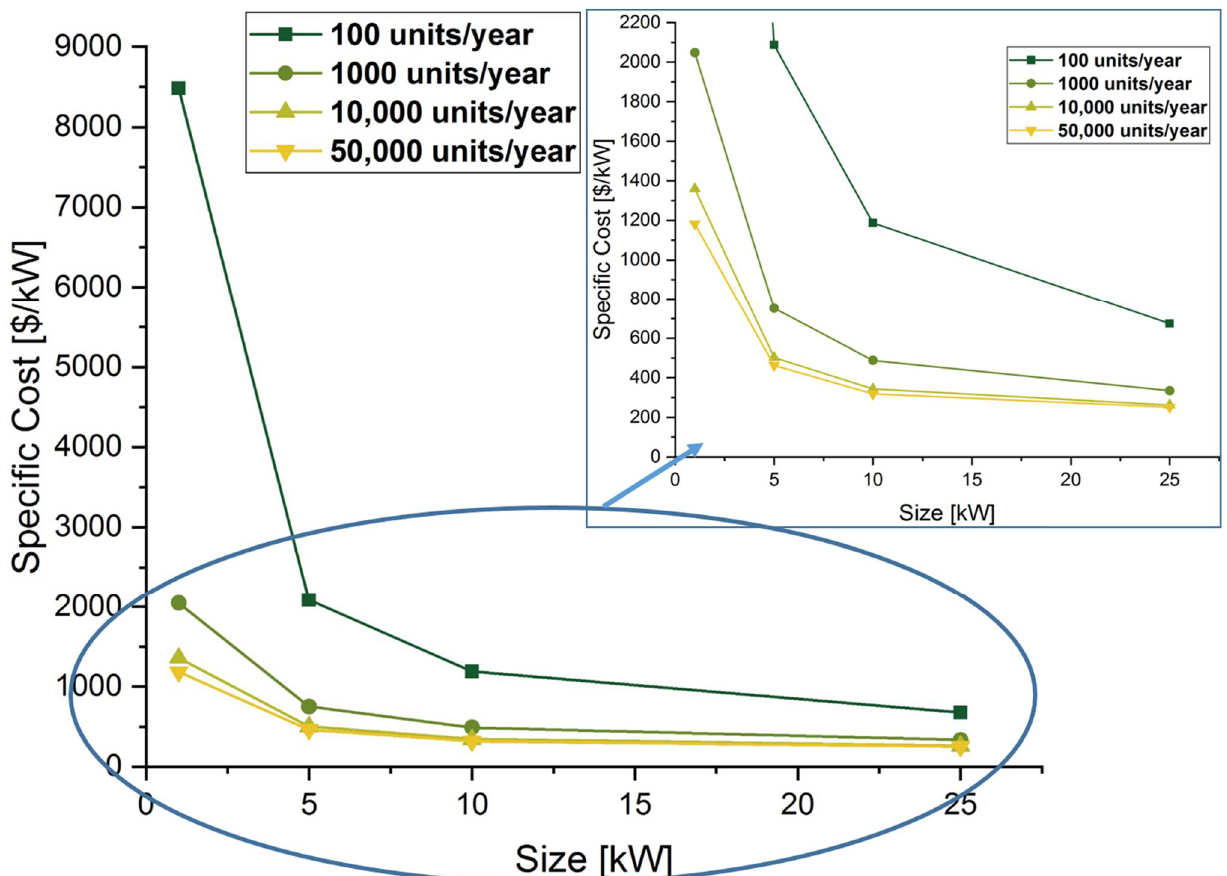
Figure 7. SOFC Ceramic Cell Potential Cost Breakdown.